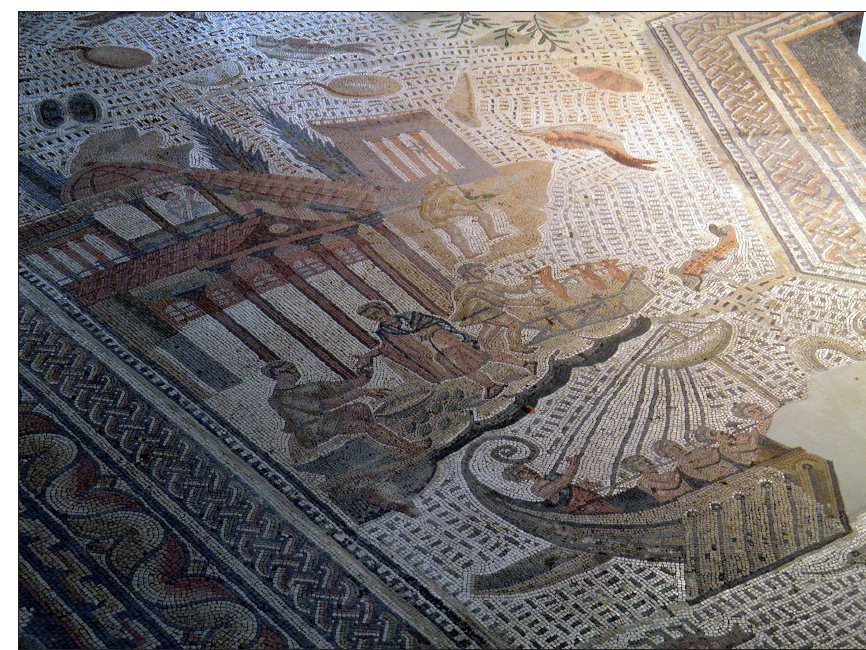
Figure 11: The Oceanus mosaic at Bad Kreuznach, ship and port. (Photo: Carole Raddato, licensed under Creative Commons Attribution-Share Alike 2.0 Generic